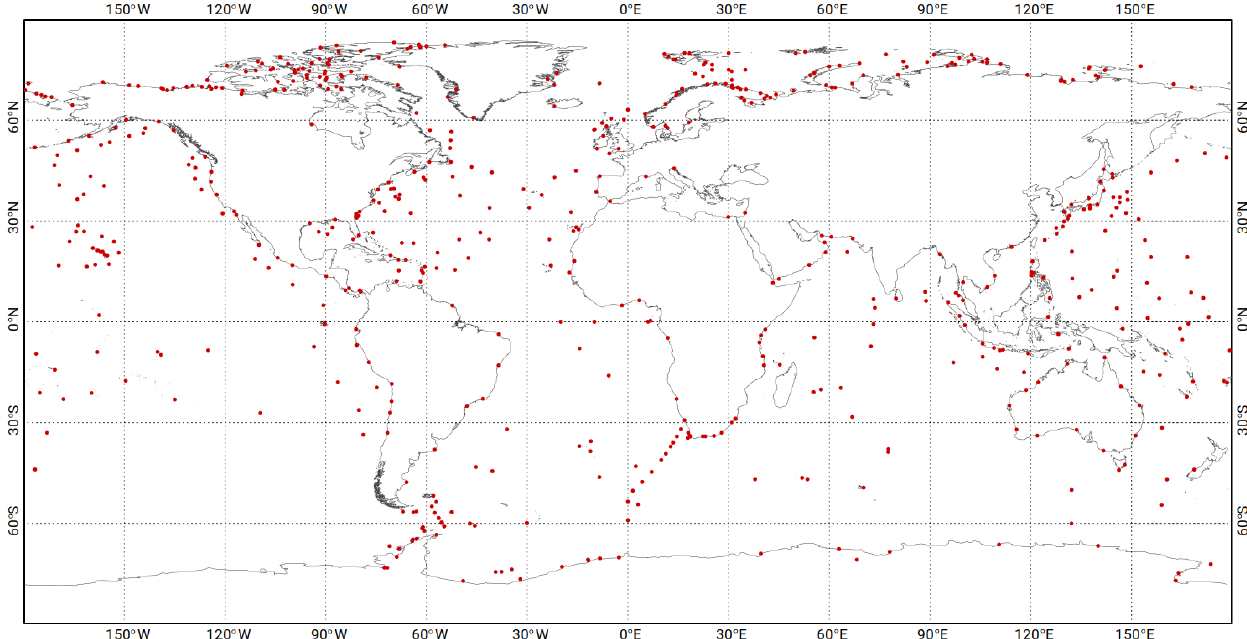
Figure 11. The 600 TG stations selected for the data assimilation. It includes 151 BPR deep ocean TG from R. Ray, 249 GLOSS coastal TG, 33 Antarctica BPR deep ocean TG, 164 TG from LEGOS composite database (including 15 TG in the Canadian Archipelago and 13 in the Baffin Sea), 4 TG from R. Ray shelf database north of Florida (Gray’s Reef, Georgia, US, denoted GR; R2, offshore GR; R5, offshore GR, R6, offshore GR), and 1 TG from British Oceanographic Data Centre (BODC) at